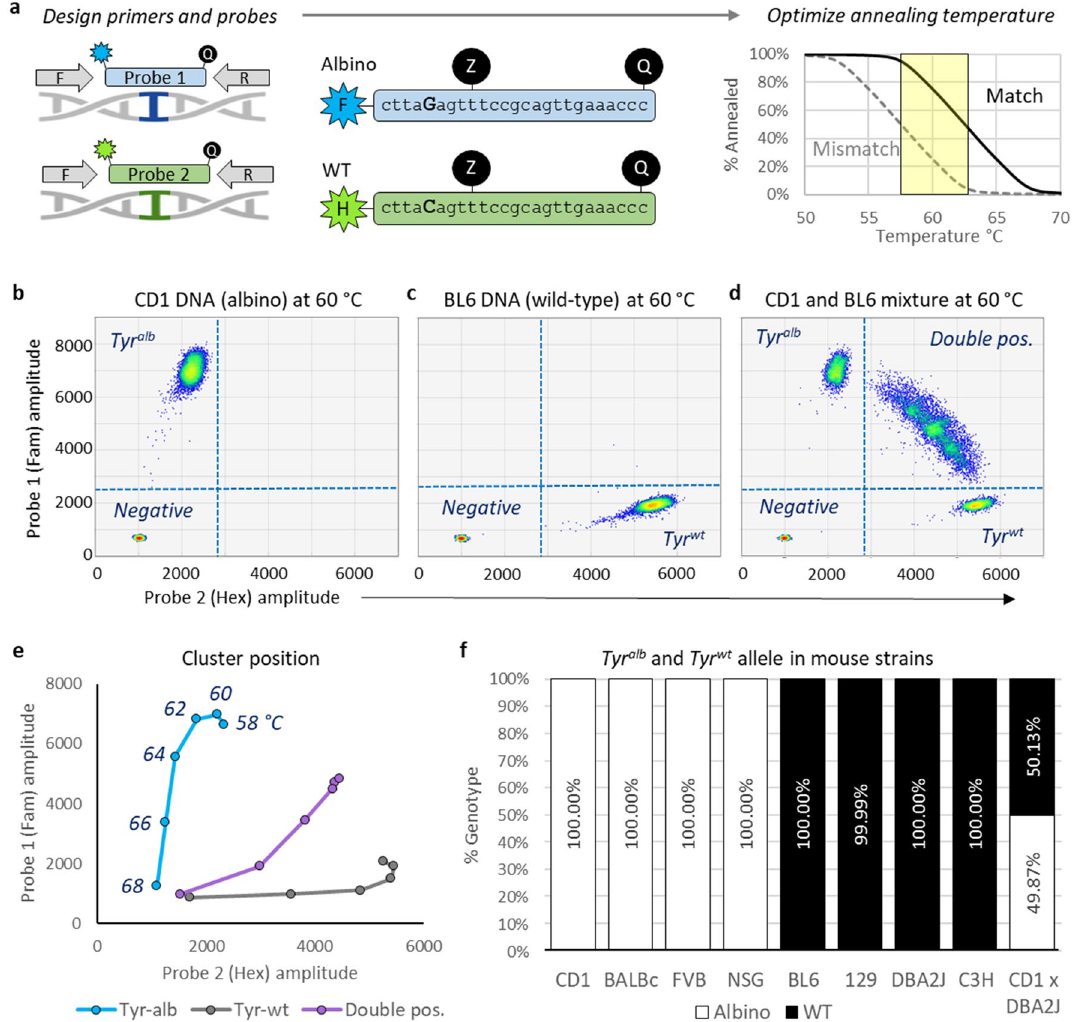
Figure 2. SND-ddPCR assay development and optimization. ( a ) Schematic representing primer/probe annealing and optimization strategy for the SND-ddPCR assay. Left: F and R indicate shared forward and reverse primers, respectively. Probes 1 and 2 are hydrolysis probes with FAM (blue) or HEX (green) fluorophores on the 5 ′ (left) end, and a quencher on the 3 ′ (right) end. Middle: Sequence of probes used to detect albino or WT allele. Internal ZEN quencher (Z) was used to reduce background. A bold letter indicates single-base difference between probes. Right: Theoretical melt curve for hydrolysis probes. The solid line represents probe annealing when all bases are matched to the target; the dashed line represents annealing with a single base mismatch. The ideal temperature range for SND assays is highlighted in yellow, which results in maximum separation between matched and mismatched annealing. ( b – d ) 2D display of SND-ddPCR results. Clusters composed of positive or negative microreactions are shown as a heat map in each quadrant. CD1 (1362 copies/µl), BL6 (1353 copies/µl) and CD1 + BL6 mixture (combined 2719 copies/µl) are shown in ( b ), ( c ), and ( d ), respectively. ( e ) 2D display showing centroid of the Tyr Alb , Tyr WT , and the double-positive cluster when analyzed at various annealing temperatures. The highest temperature is shown at the bottom left, and the lower temperatures move along the respective line upward and/or rightward. ( f ) Frequency of Tyr Alb and Tyr WT allele detected in various mouse strains. CD1xDBA2J is an F1